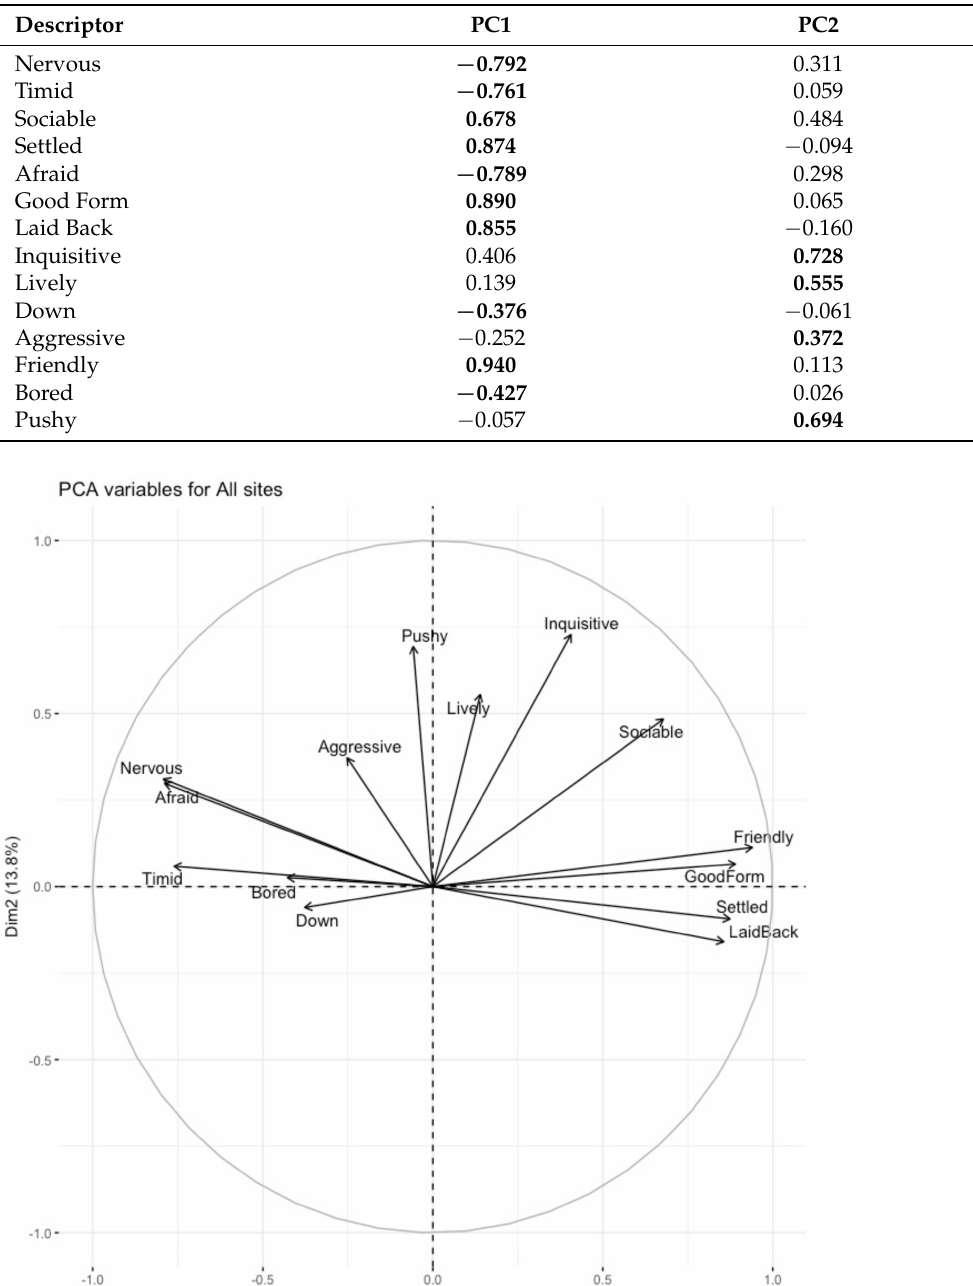
Table 8. QBA descriptors in the two main dimensions (PC1, PC2) representing mood and energy and their loadings. The strongest loadings across both dimensions are bolded.